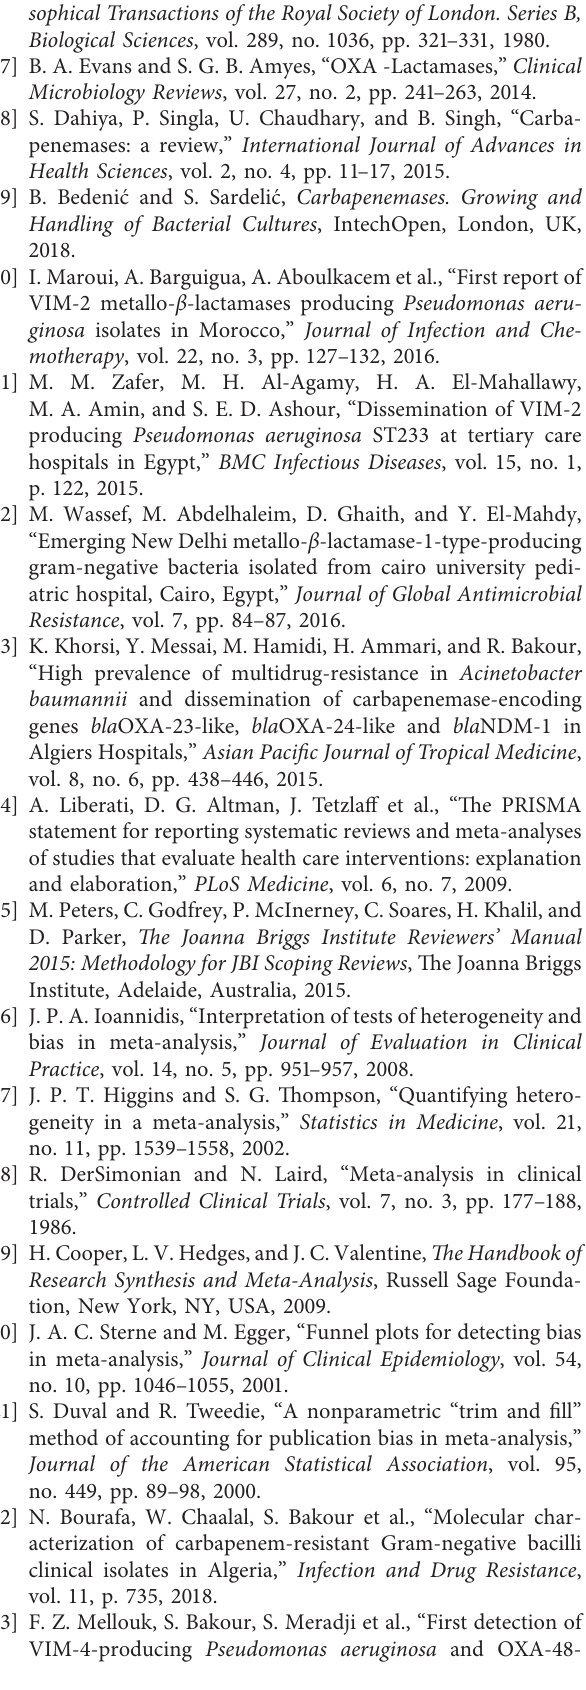
Figure S1: forest plot for the pooled prevalence of CPPA among CRPA isolates in Africa. Figure S2: the subgroup analysis showed the pooled prevalence of CPPA isolates in Africa by region. Table S3: Egger’s regression test for publication bias of CPPA. Figure S4: forest plot for the pooled prevalence of CPAB among CRAB isolates in Africa. Figure S5: the subgroup analysis showed the pooled prev- alence of CPAB isolates in Africa by Region. Table S6: Egger’s regression test for publication bias of